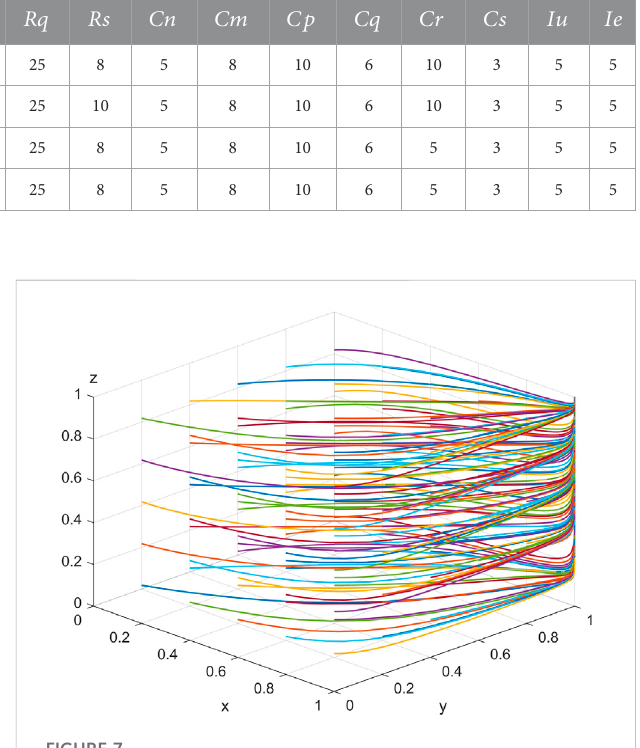
FIGURE 7 System evolution process in the steady development